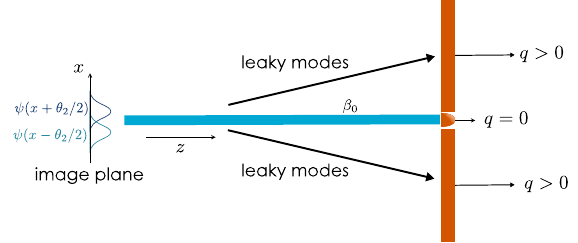
FIG. 7. An alternative design of binary SPADE with a single- mode waveguide and leaky-mode